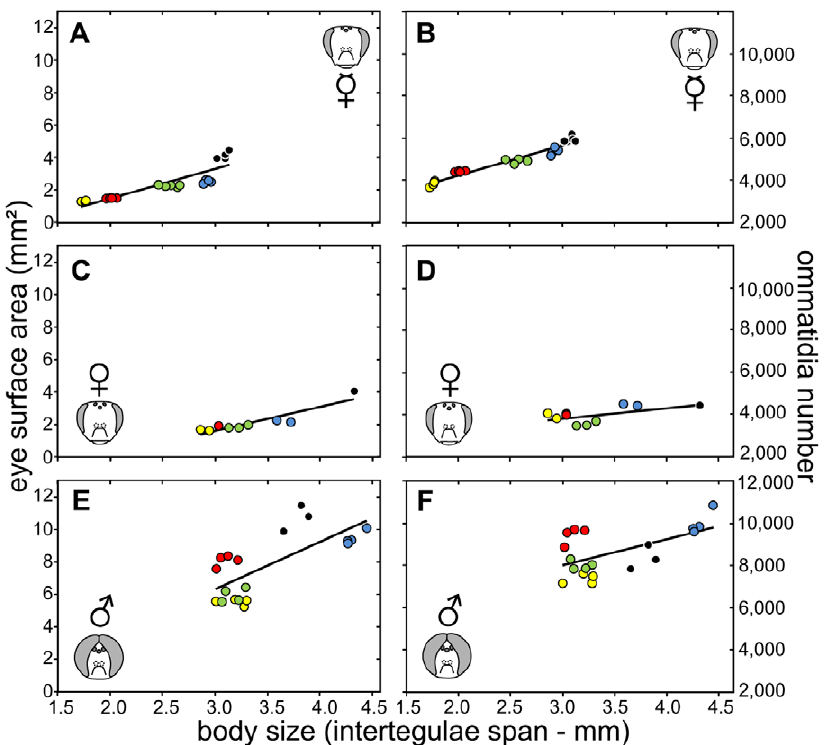
Figure 1. Morphological measurements of eye parameters in five honeybee species. Eye surface area (left panel) and ommatidia number (right panel) measured in workers (A, B), queens (C, D) and drones (E, F) of the Western and four Asian honeybee species. Species are indicated by color ( A. andreniformis – yellow, A. florea – red, A. dorsata – black, A. mellifera – blue, A. cerana – green). Each circle represents one measured individual (see Table 1 for sample sizes). Trend lines are based on all measured specimens (A: y=1.82x 2 2.15, R 2 =0.79; B: y=1,421.66 x + 1,399.65, R 2 =0.94; C: y=1.46x 2 2.75, R 2 =0.81; D: y=514.11x + 2,312.18, R 2 =0.38; E: y=2.88x –2.29, R 2 =0.51; F: y=1,250.49x + 4,264.23, R 2 =0.34).